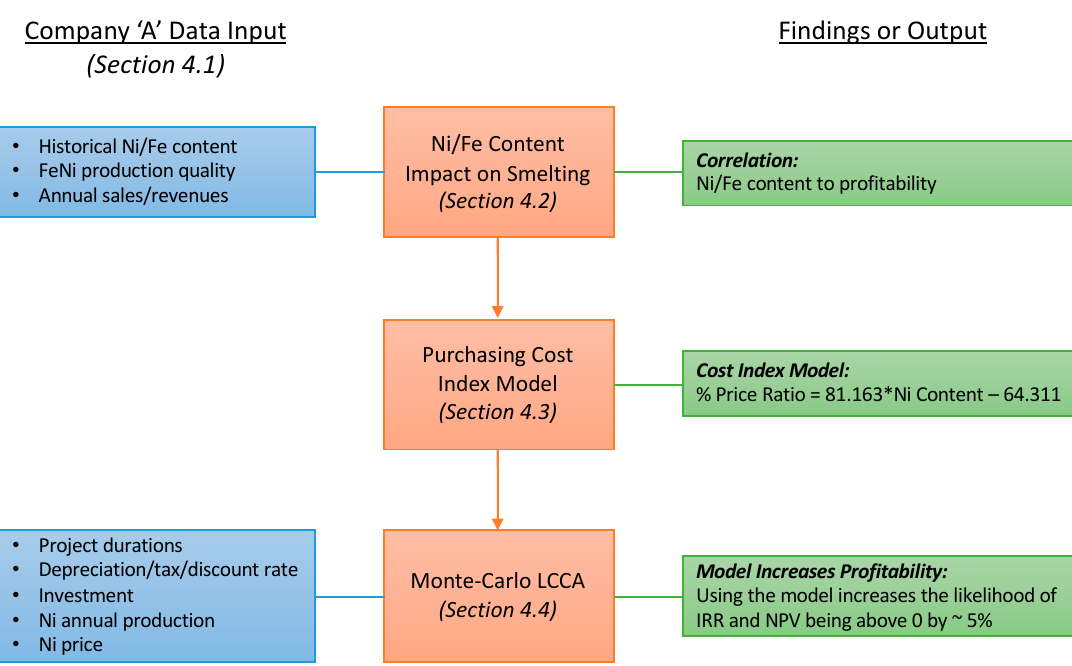
Figure 2. Research methodology flow.